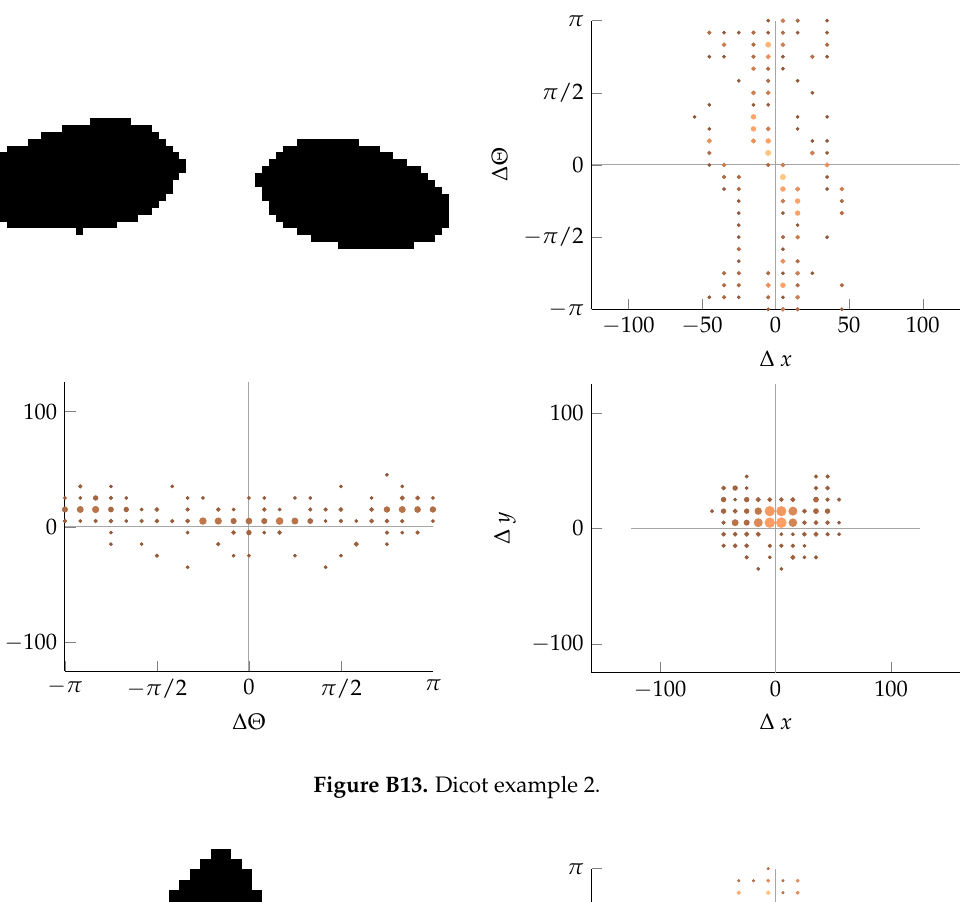
Figure B13. Dicot example 2.